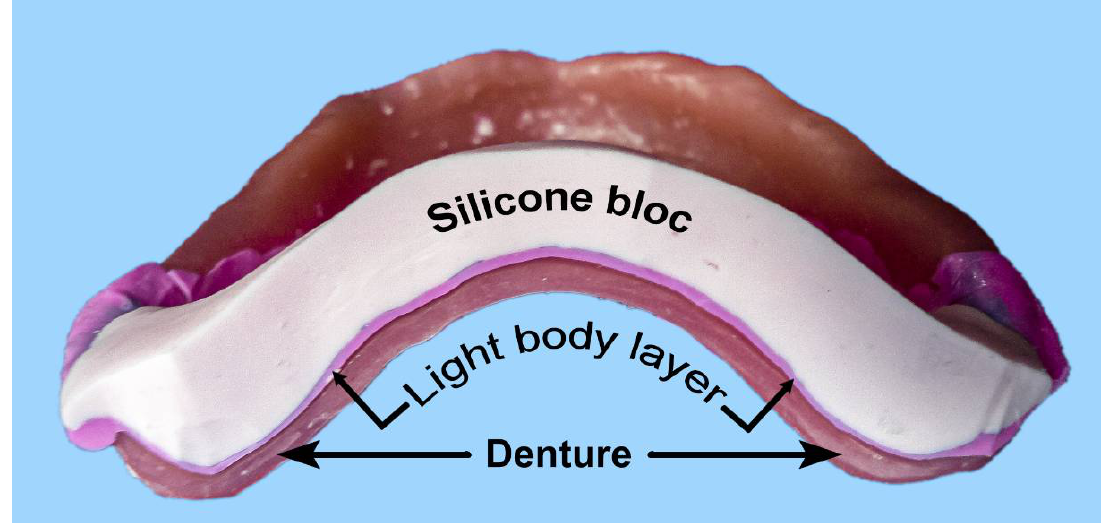
Figure 3. Image of the gap captured with impression material, stabilised with a silicone bloc.